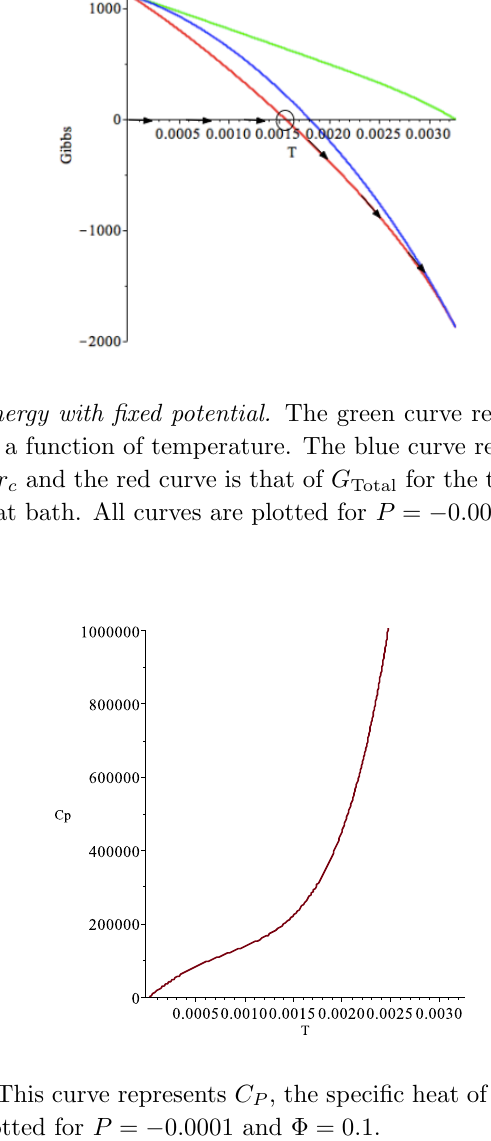
the critical temperature